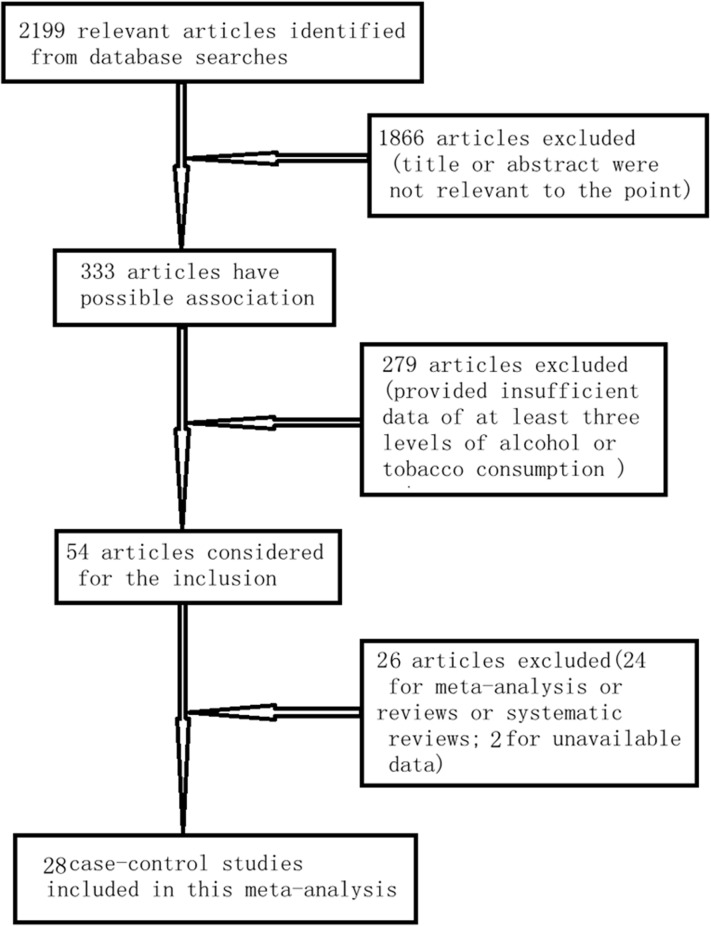
Flowchart of selection of studies for inclusion in meta-analysis.